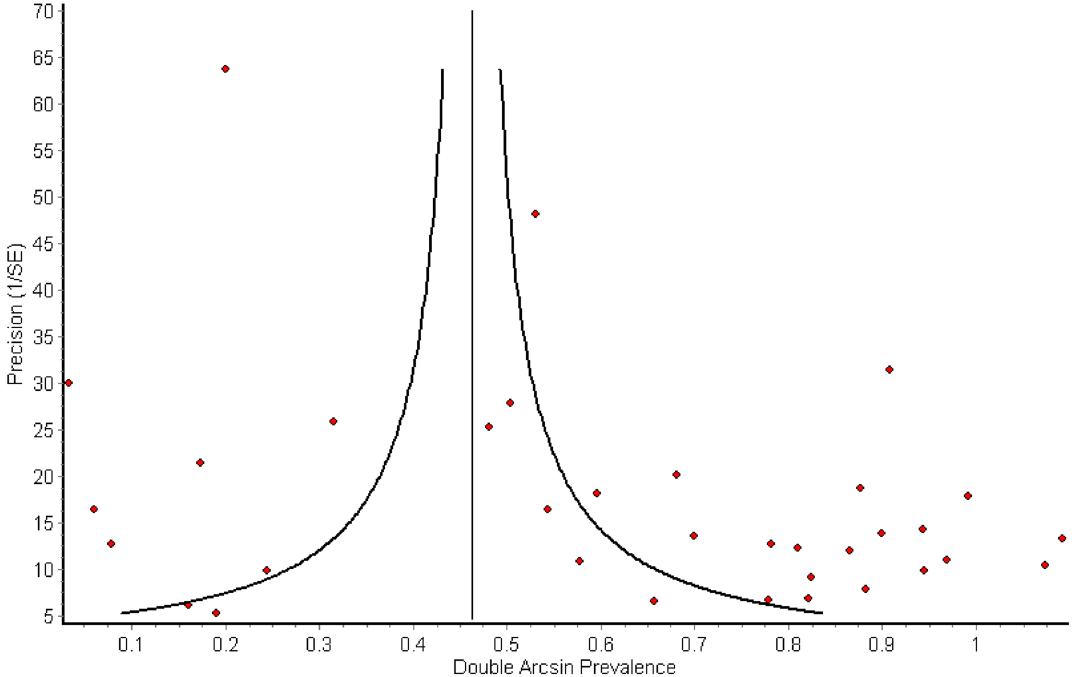
Figure 3. Funnel plot of published studies (n = 34) on Brucella seroprevalence in African wildlife showing study precision vs. transformed prevalence estimate. Curved lines indicate cut-off for statistically significant difference ( P < 0.05) vs. pooled estimate (vertical line).